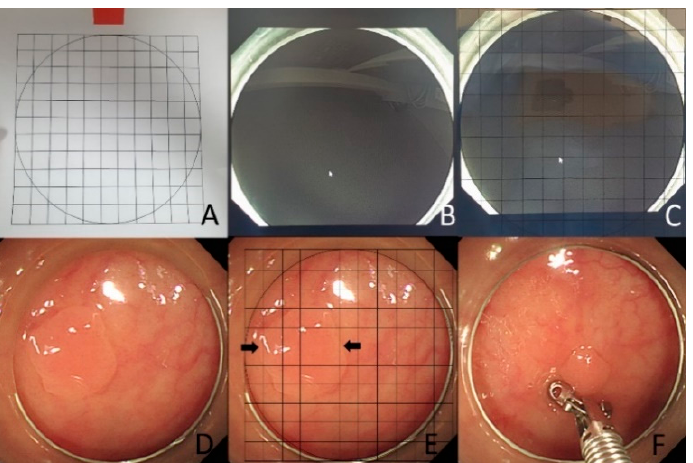
Figure 1. ( A ) The grid was drawn on a transparent vinyl paper with 1-mm intervals, ( B , C ). the grid paper was fixed at the inner circle of the colonoscopic cap on monitor, ( D , E ). When detected a polyp, the endoscopist attached the cap and measured the polyp size by counting on the external grid, ( F ). In this study, we additionally measured the polyp size with